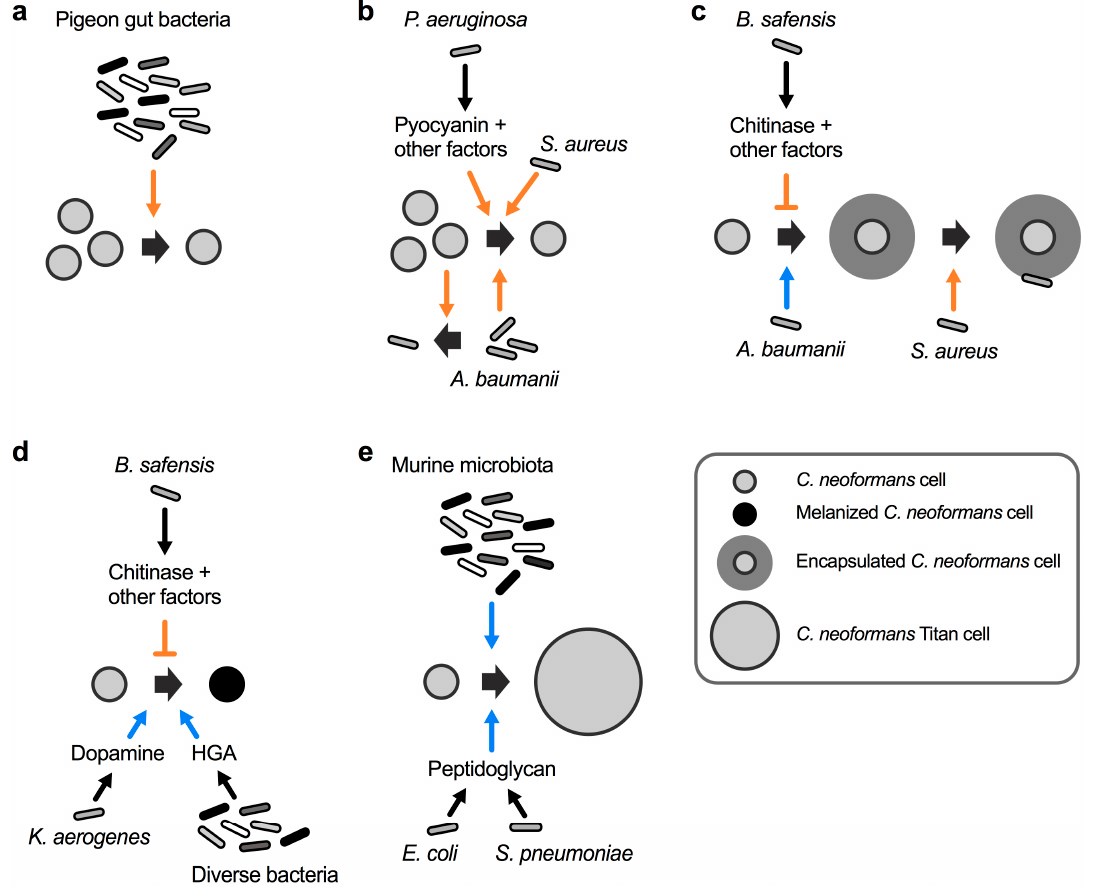
Figure 2. The spectrum of interactions between C. neoformans and bacteria. ( a ) A mixture of bacteria isolated from the gastrointestinal tract of healthy pigeons kills C. neoformans . ( b ) Acinetobacter baumanii and C. neoformans reciprocally inhibit each other’s growth. Staphylococcus aureus kills C. neoformans by an unknown mechanism, and P. aeruginosa kills cryptococcal cells via production of pyocyanin and other factors. ( c ) A. baumanii induces C. neoformans capsule formation, and S. aureus preferentially attaches to and kills encapsulated C. neoformans cells. Bacillus safensis inhibits capsule formation via production of chitinase and other factors. ( d ) K. aerogenes produces dopamine, and diverse bacteria produce homogentisic acid (HGA), both of which serve as substrates for cryptococcal melanin biosynthesis. B. safensis inhibits fungal melanin production via chitinase activity and other factors. ( e ) Cell wall peptidoglycan from E. coli and Streptococcus pneumoniae induce C. neoformans titan cell formation. The murine microbiota induces fungal titanization by an unknown mechanism. The orange colored arrow-headed and blunt-ended lines indicate inducing and repressive processes, respectively, that have a negative impact on cryptococcal viability or virulence factor production. The blue colored arrow-headed lines indicate processes that have a positive influence on the formation of C. neoformans virulence factors.